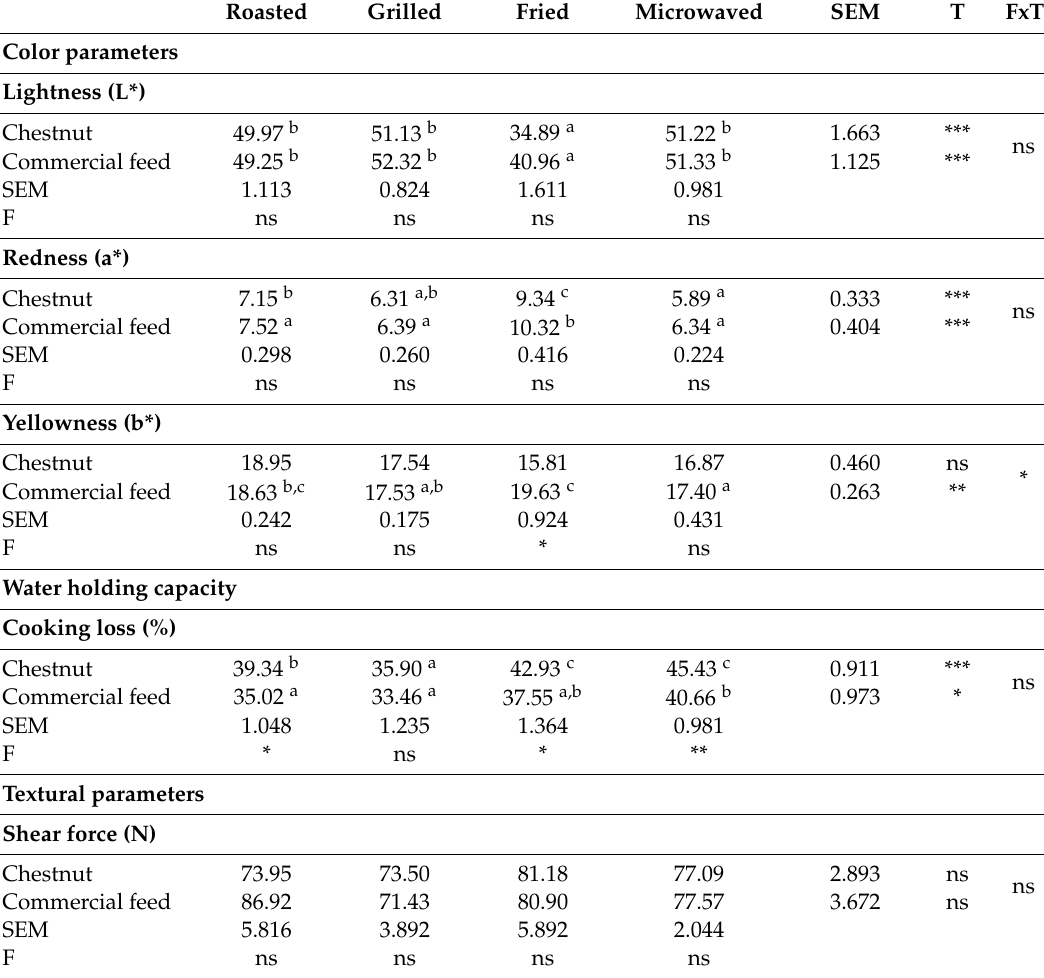
Table 2. E ff ects of the inclusion of chestnut in the finishing diet and of cooking methods on color parameters, water holding capacity and textural parameters of Celta pig Biceps femoris